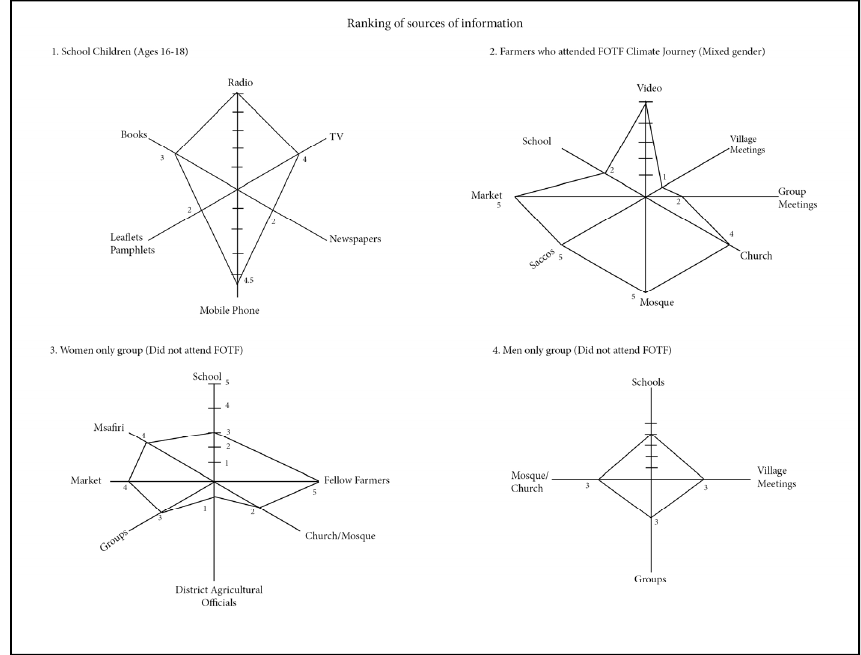
Figure 5. Cobweb diagram showing ranking on importance of sources of information for CSA practices and technologies.